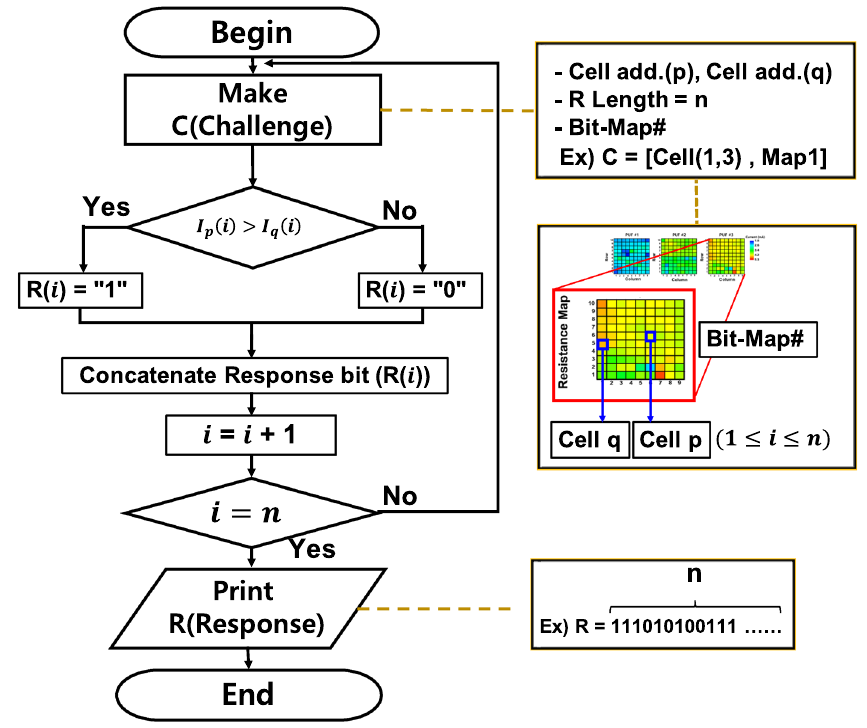
Figure 3. Schematic of CRP generation algorithm. When a request for CRP generation arrives, a challenge (C) is generated that comprises two particular cells from a specific PUF device and a response length (R). Comparing the currents of the first and second selected cells produces a bit represented by 0 or 1. Concatenating each bit into the response bits, the CRP is completed as a response of n